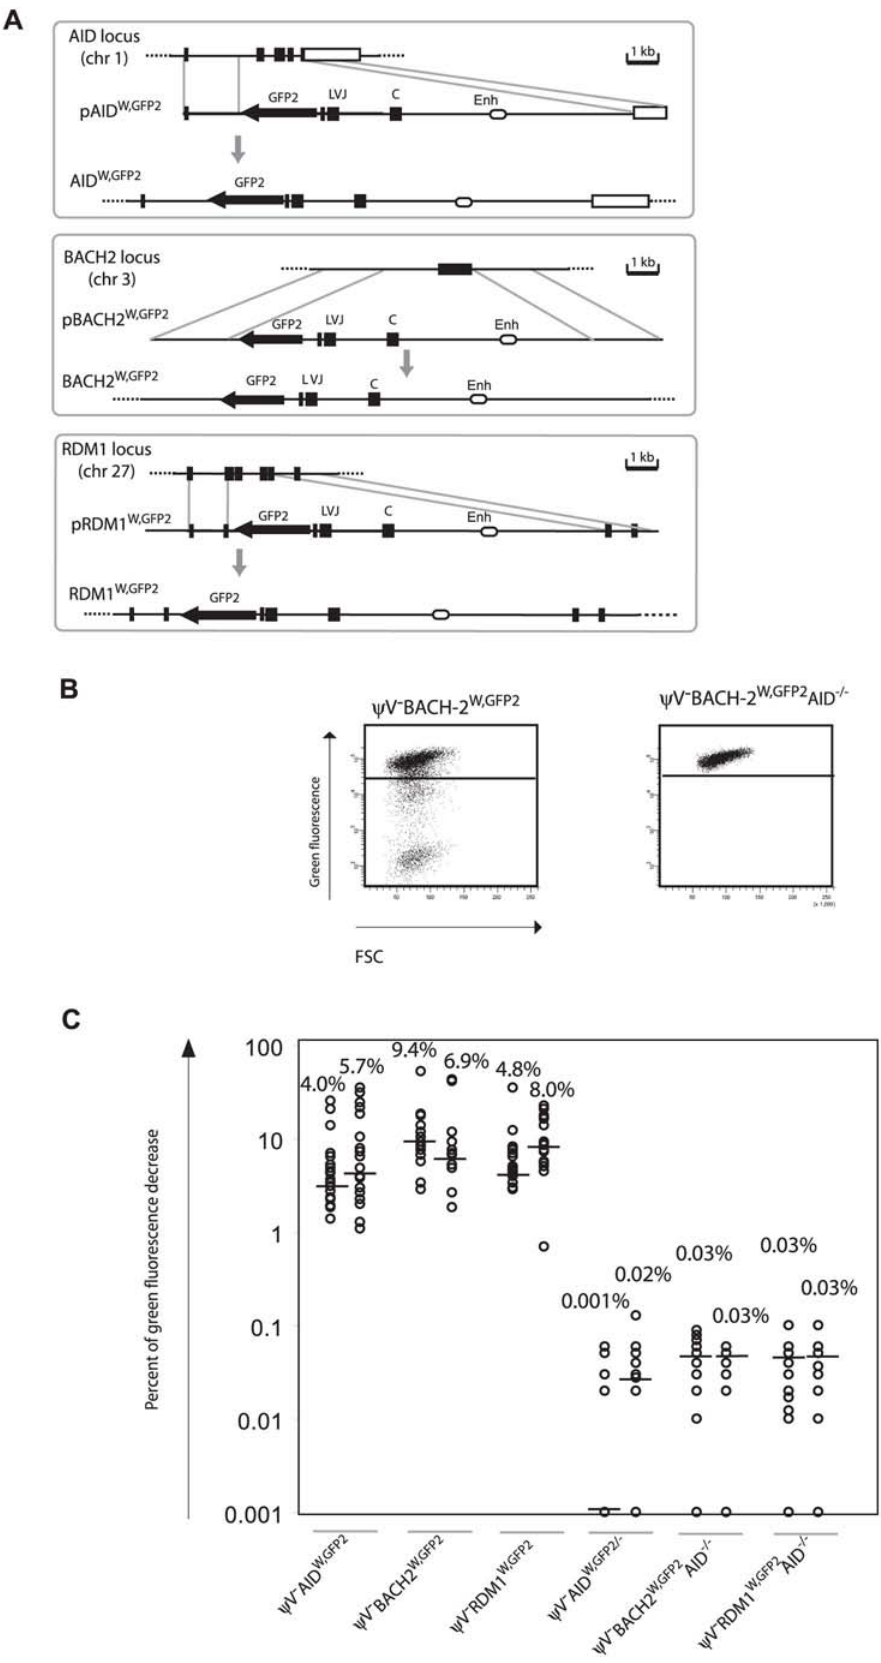
Figure 5. Hypermutation of the GFP2 reporter at non-Ig loci in the presence of the ‘ W ’ fragment. (A) Physical maps of the non-Ig loci, the targeting constructs including the GFP2 reporter together with the ‘ W ’ fragment and the loci after targeted insertion of the GFP2 reporter. (B) FACS analysis of primary AID positive and AID negative transfectants. (C) Fluctuation analysis of subclones. doi:10.1371/journal.pgen.1000332.g005 PLoS Genetics |